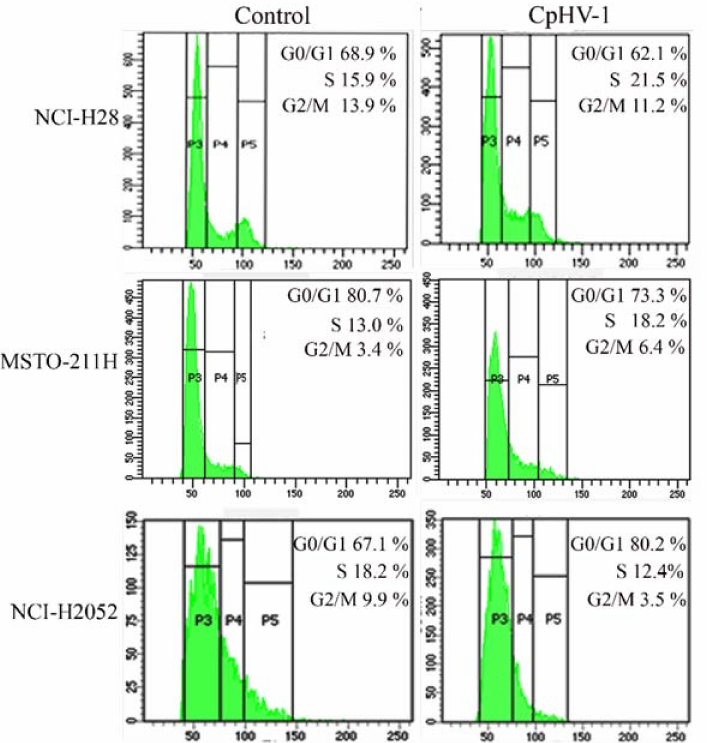
Figure 3. Effect of caprine herpesvirus 1 (CpHV-1) on mesothelioma cell cycle progression. A representative cell cycle profile, based on two independent FACS analyses performed on each MM cell line (NCI-H28, MSTO-211H, and NCI-H2052) upon infection with CpHV-1 (5 MOI, multiplicity of infection), is